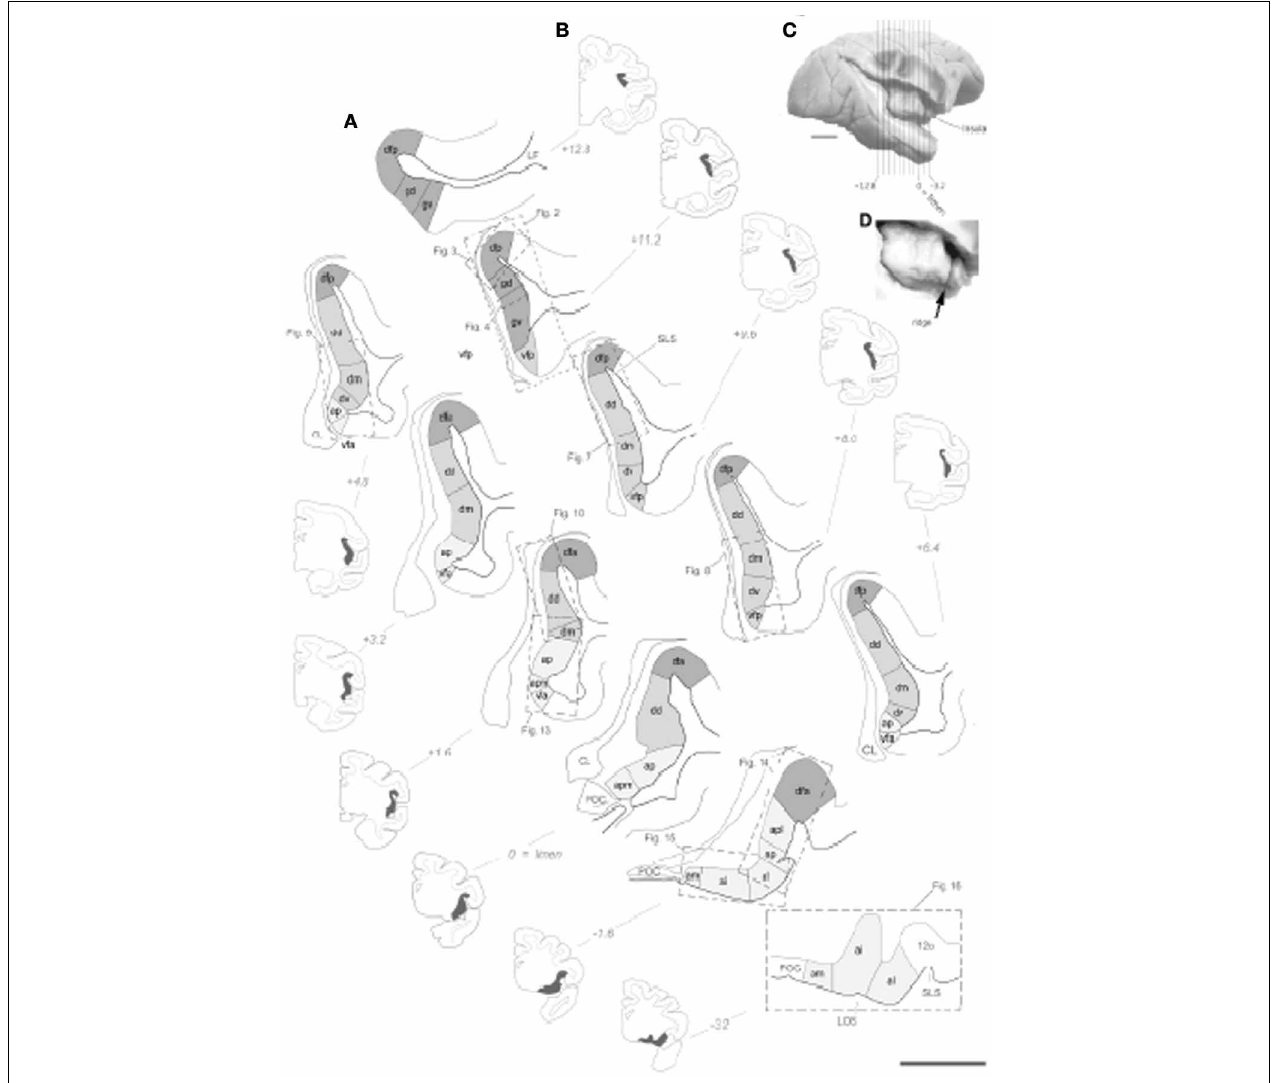
FIGURE 1 | Illustration of the topographical localization of the 15 distinct architectonic areas of the insular cortex in one set of drawing of 11 coronal sections from the right hemisphere from one representative case cm6R. (A) Drawing of the 15 architectonic areas and borders. The granular dysgranular and agranular areas are distinguished by darker, intermediate and light gray tones, respectively. Scale bar = 2.5mm. (B) Low magnification and simplified drawing of the entire coronal section from which